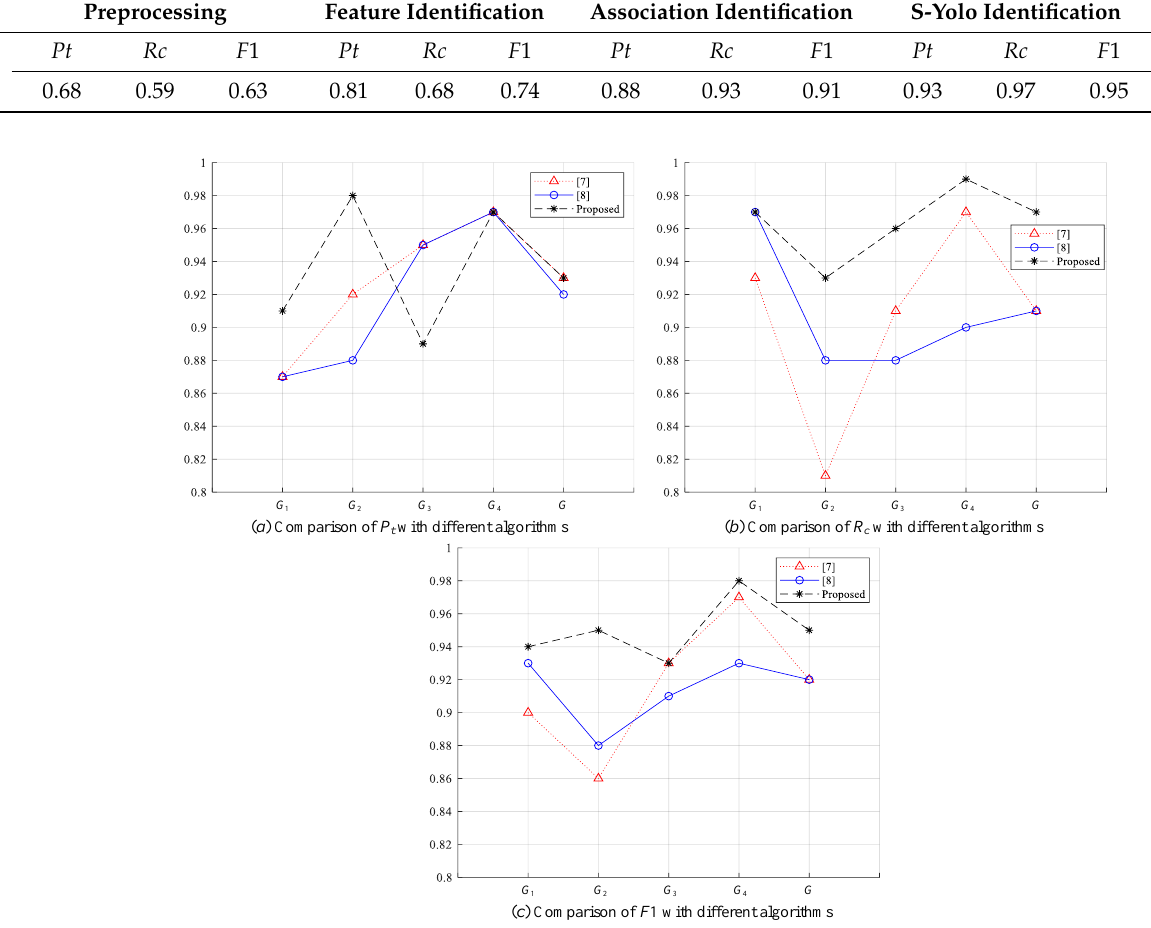
Figure 6. Comparison of ship target detection performance between the traditional Yolo algorithm and the proposed algorithm.